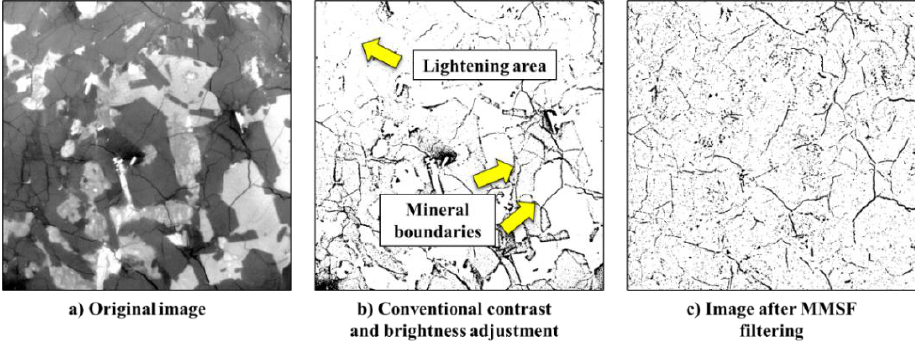
Figure 4. Comparisons between ( a ) original image, ( b ) conventional image enhancement, and ( c )